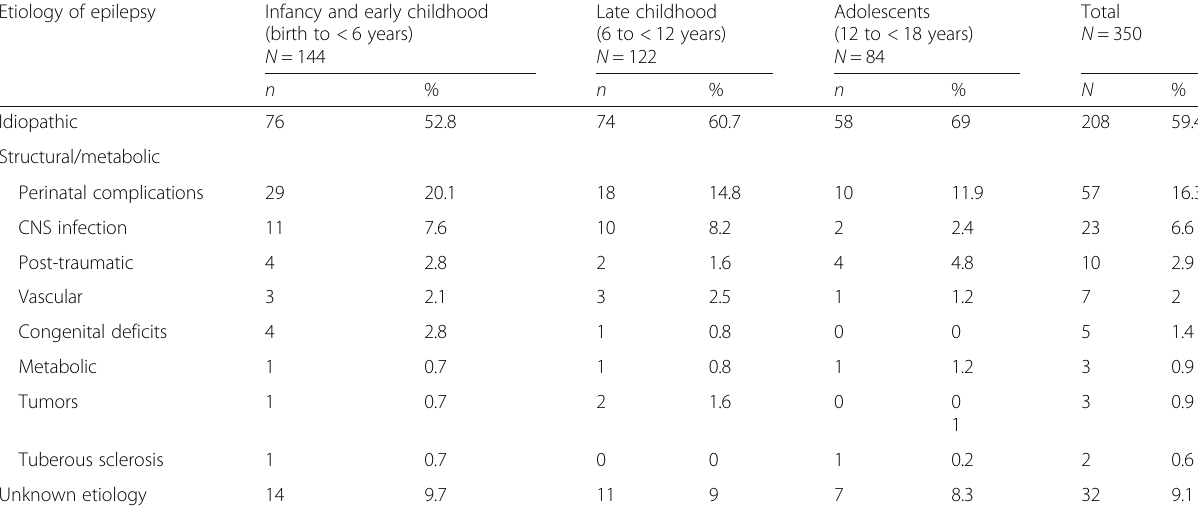
Table 4 Distribution of different etiologies among studied epileptic groups Etiology of epilepsy Infancy and early childhood (birth to < 6 years) N = 144 Idiopathic